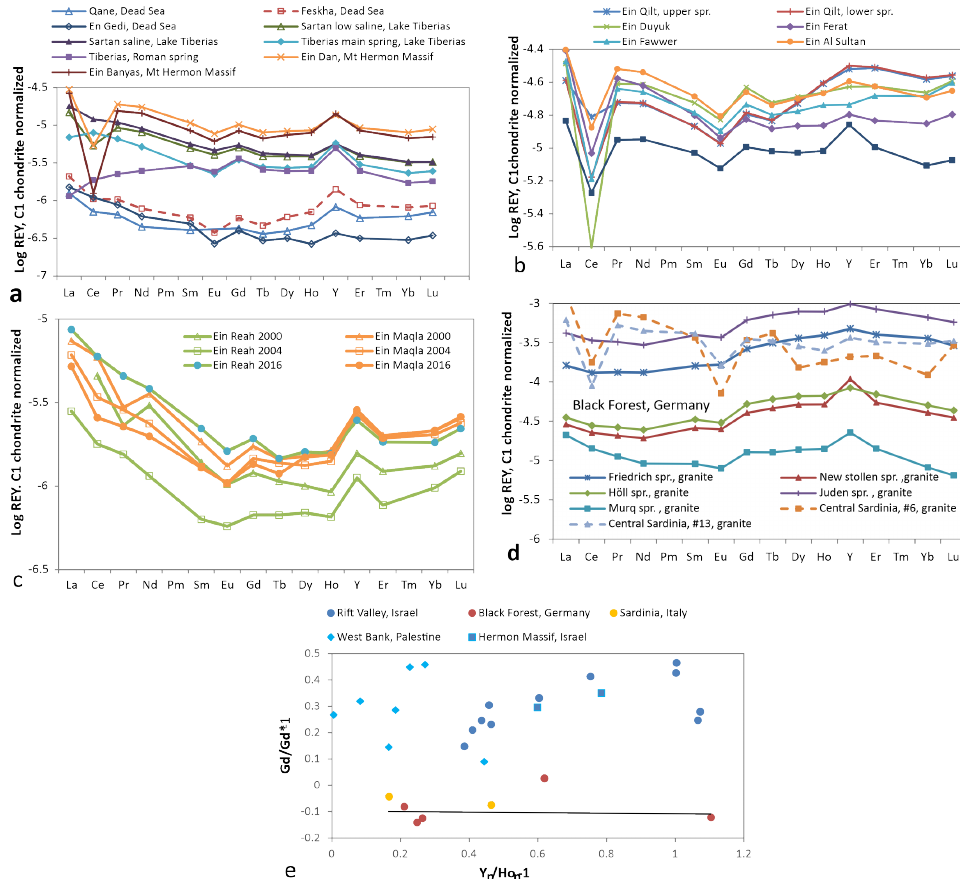
Figure 7. REY in groundwater from springs. ( a ) Rift Valley, Isreal, ( b ) Westbank (unpublished data from springs in limestone); ( c ) Yarmouk Gorge, hot springs in Israel; (d) Black Forest (springs from granites; ref. [76] and springs from granitoids in Central Sardinia, Italy [77]); ( e ) Correlation of Gd and Y anomalies. Gd anomalies in samples from felsic rocks are between 0.15 and +0.05, whereas those from limestones scatter between 0.1 and 0.5. Y anomalies spread like in the limestone